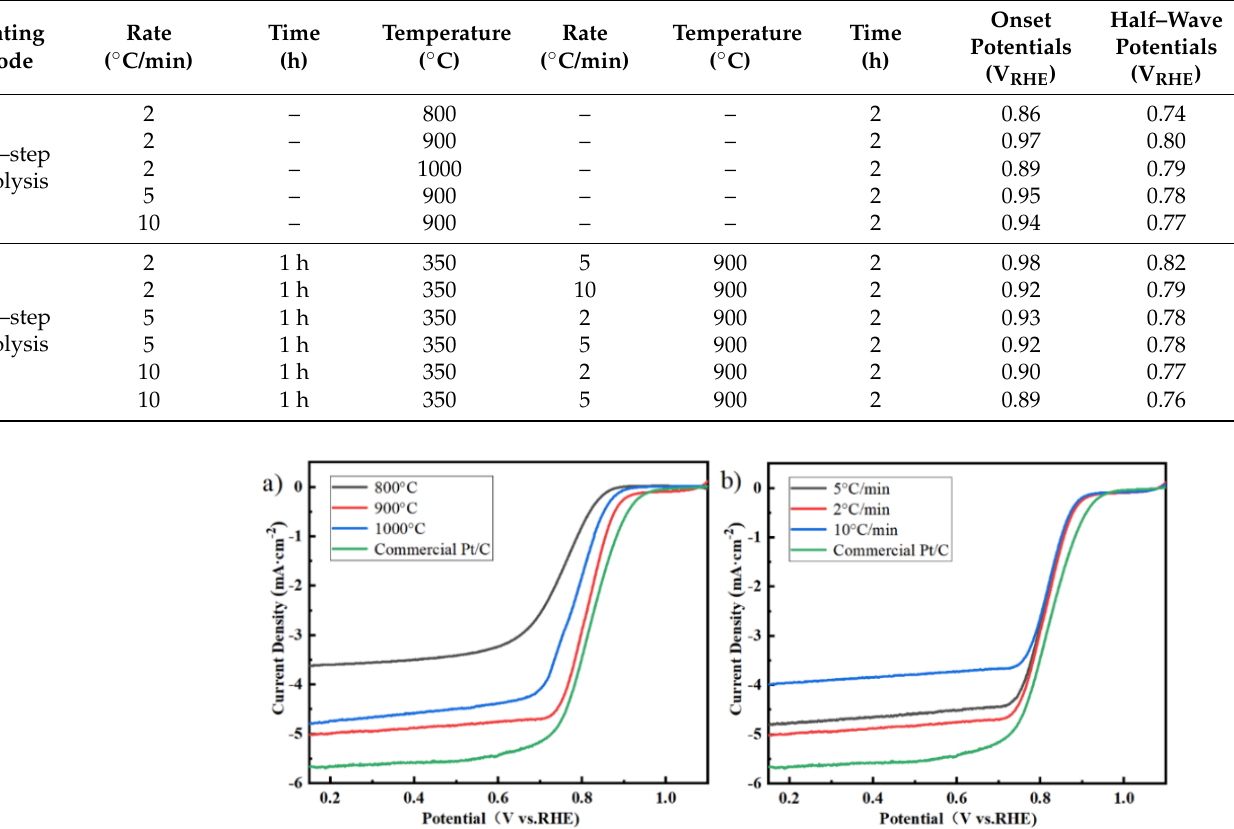
Figure 2. ( a ) LSV curves of Co–ZIF–8 pyrolyzed at different temperatures, ( b ) LSV curves of Co–ZIF–8 pyrolyzed at heating rates.